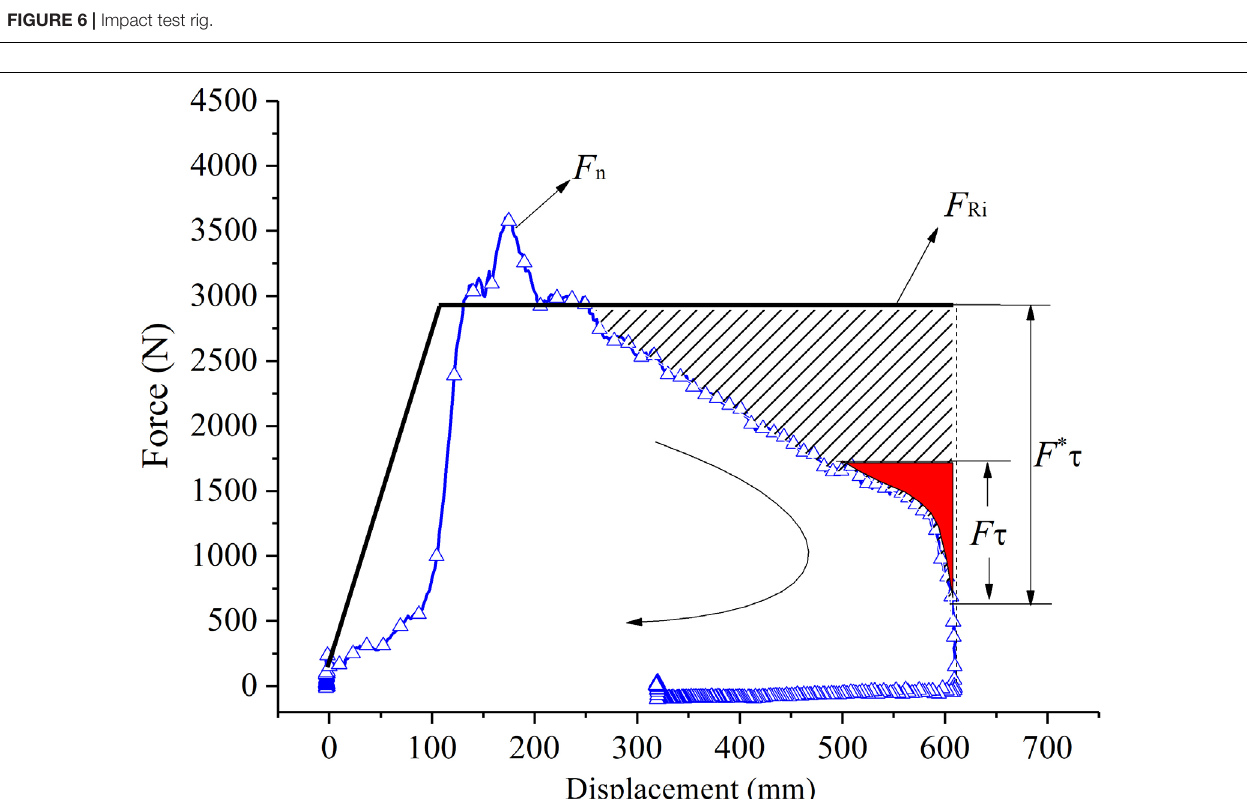
FIGURE 7 | Comparison of actual and ideal “platform effect” recoil curves.